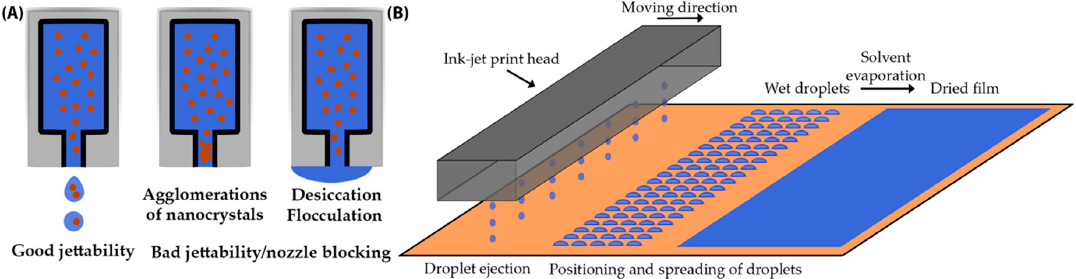
Figure 1. Schematic illustration (not to scale) of ink-jet printing of a YBCO nanocomposite film. ( A ) Careful adjustments of the jettability depending on the used inks. The agglomerations of nanocrystals and fast desiccation / flocculation of the solvent can lead to blocked nozzles or bad jettability. ( B ) Operating principle of a drop-on-demand ink-jet printing system above a substrate.